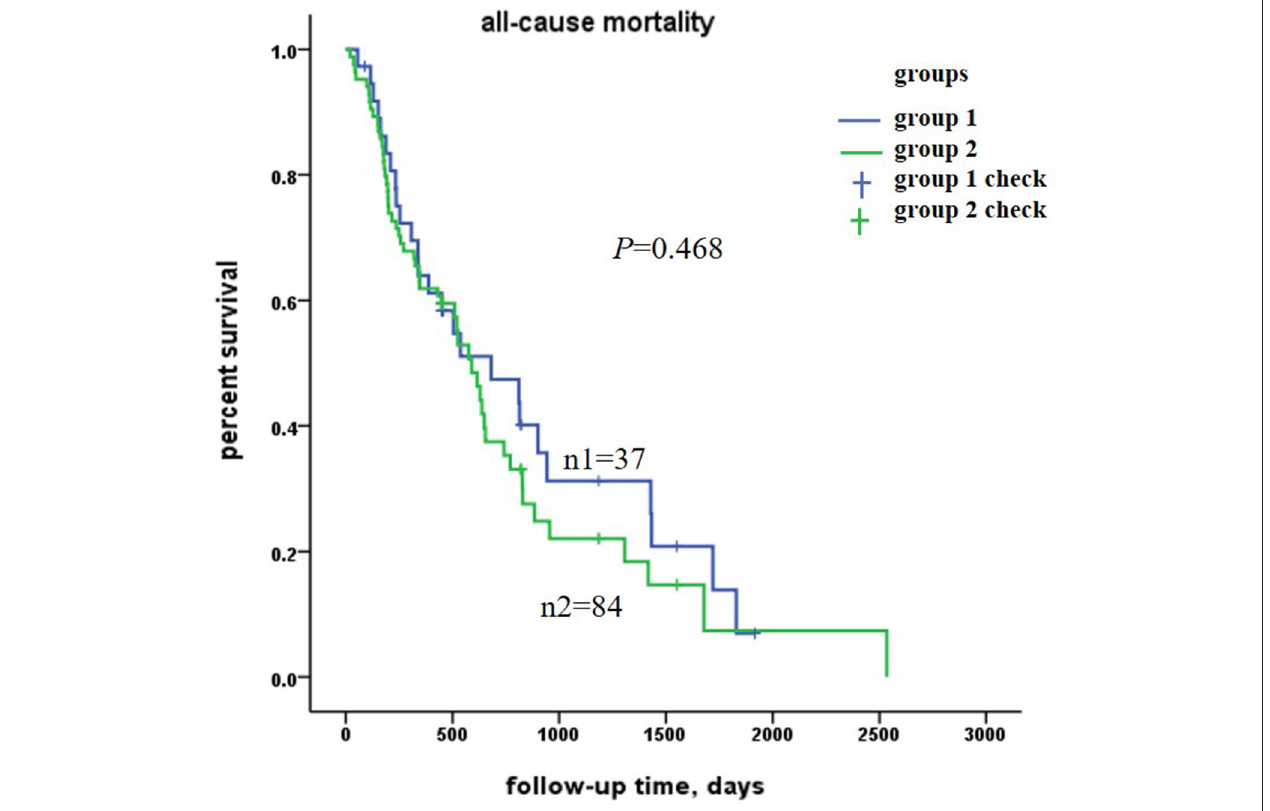
FIGURE 2 | Kaplan–Meier survival curves estimation for all-cause mortality in the 121 centenarians. There was no significant difference between group 1 and group 2. Group 1 was for lipid lowering drugs non-users, Group 2 was for lipid lowering drugs users.